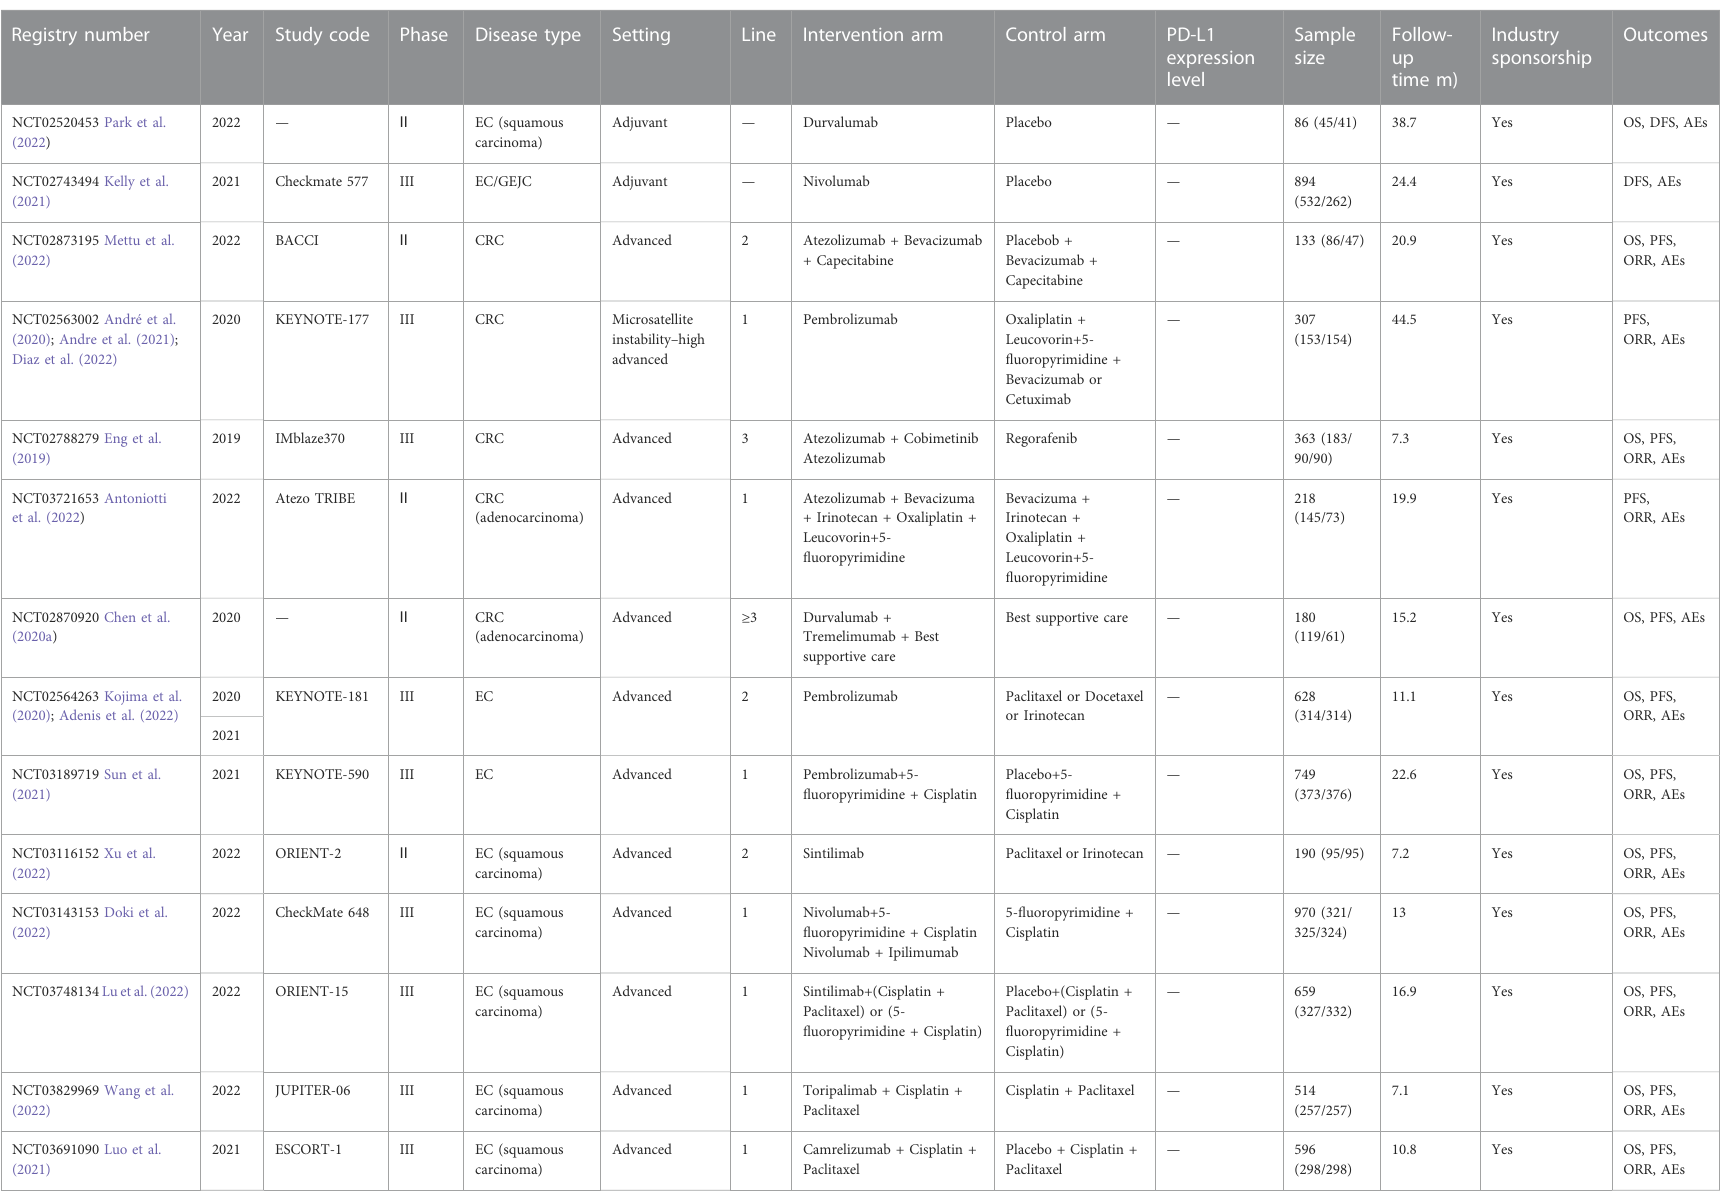
TABLE 1 Characteristics of the included